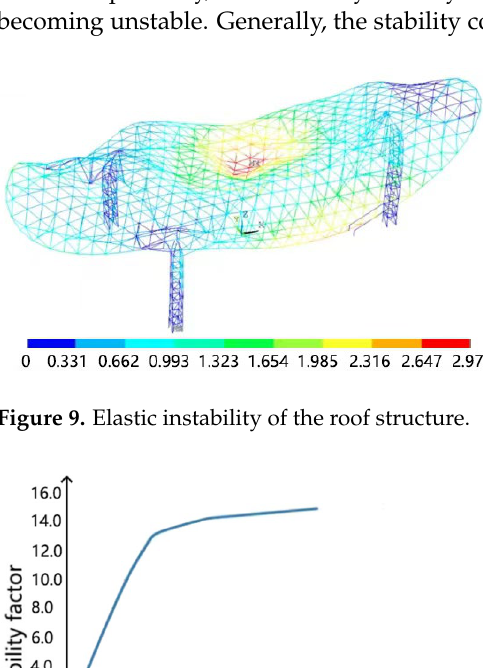
Figure 11. Elastoplastic instability of the roof structure. Figure 12. Elastic–plastic buckling state load–displacement curve. Under the elastic instability state, the bearing capacity coefficient of the roof structure can reach 14, and the unstable part occurs in the middle of the roof, which is a typical shell forking instability. In the elastic–plastic analysis, the overall deformation of the roof reaches 0.5 m, the structure has sufficient ductility, and the stable bearing capacity coeffi- cient is 3, which meets the requirements of the specification. 3.2. Performance Design Results 3.2.1. Analysis Results of Natural Lighting The natural lighting illumination is calculated for three types of atriums: all alumi- num plate rooves, aluminum plates with a glass roof, and all glass rooves. The calculation